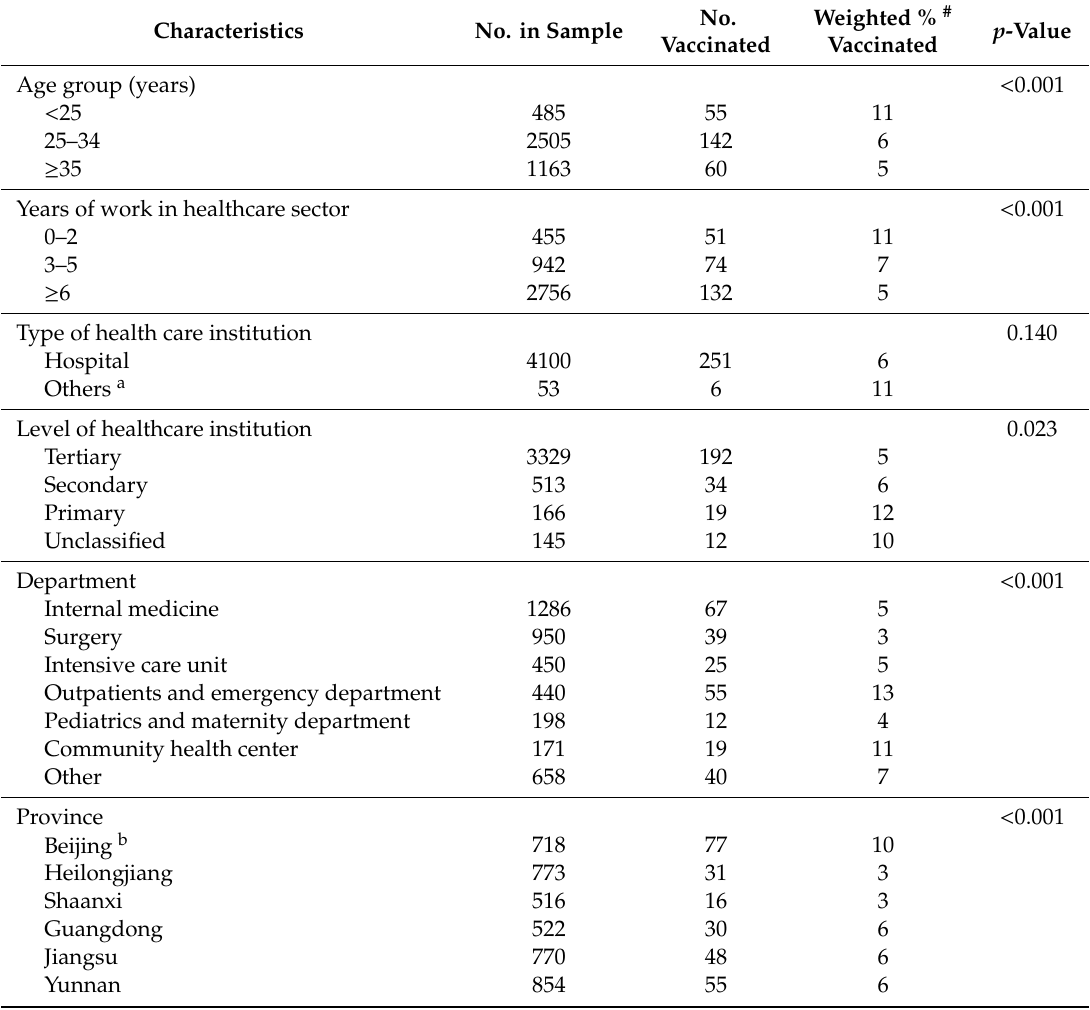
Table 2. Proportion of registered nurses who received influenza vaccination, China, 2017 /